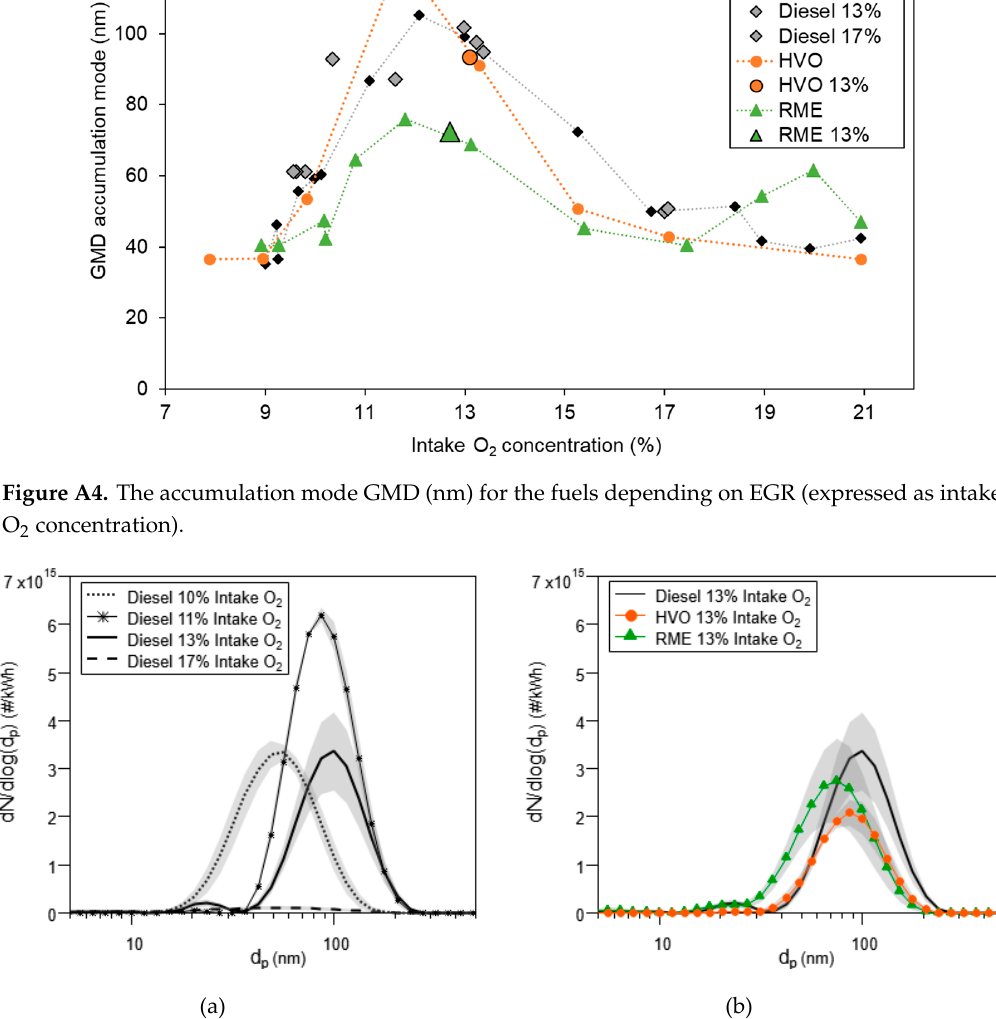
Figure A5. The average particle mobility size distribution of the filter replicates, the shadowed area represent ±1 std. dev. ( a ) The diesel samples generated at different levels of EGR (expressed as intake O 2 concentration) and ( b ) HVO and RME compared to diesel generated at 13% intake O 2 . The average particle number (PN) emission was similar for RME and diesel at 13% intake O 2 , while the PN emission was reduced around a factor 1.6 for HVO compared to diesel.